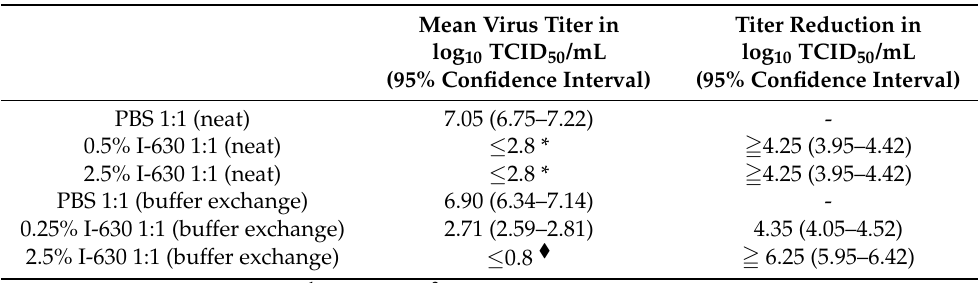
Table 1. Virus inactivation following a 20 min incubation of virus stock diluted 1:1 with 0.25 or 2.5% IGEPAL-630, or PBS, with or without buffer